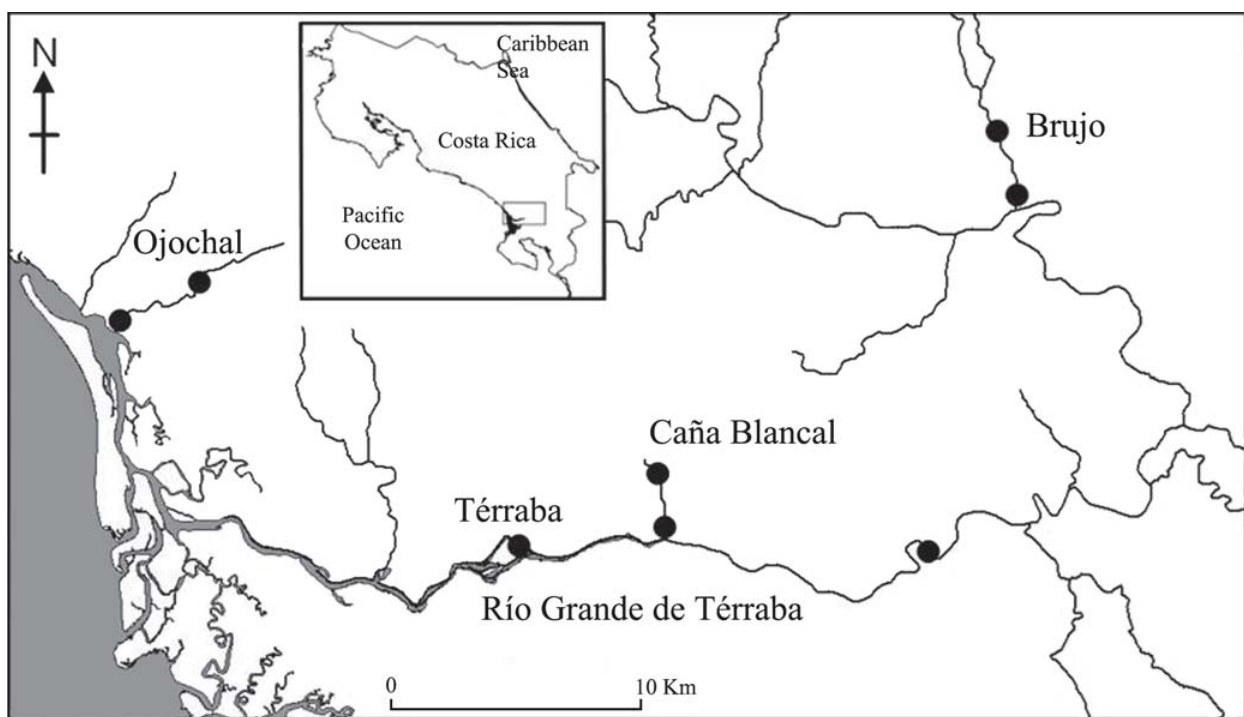
Fig. 1. Study area, the main River Térraba and Streams Ojochal, Caña Blancal and Brujo with the respective data recollection points.